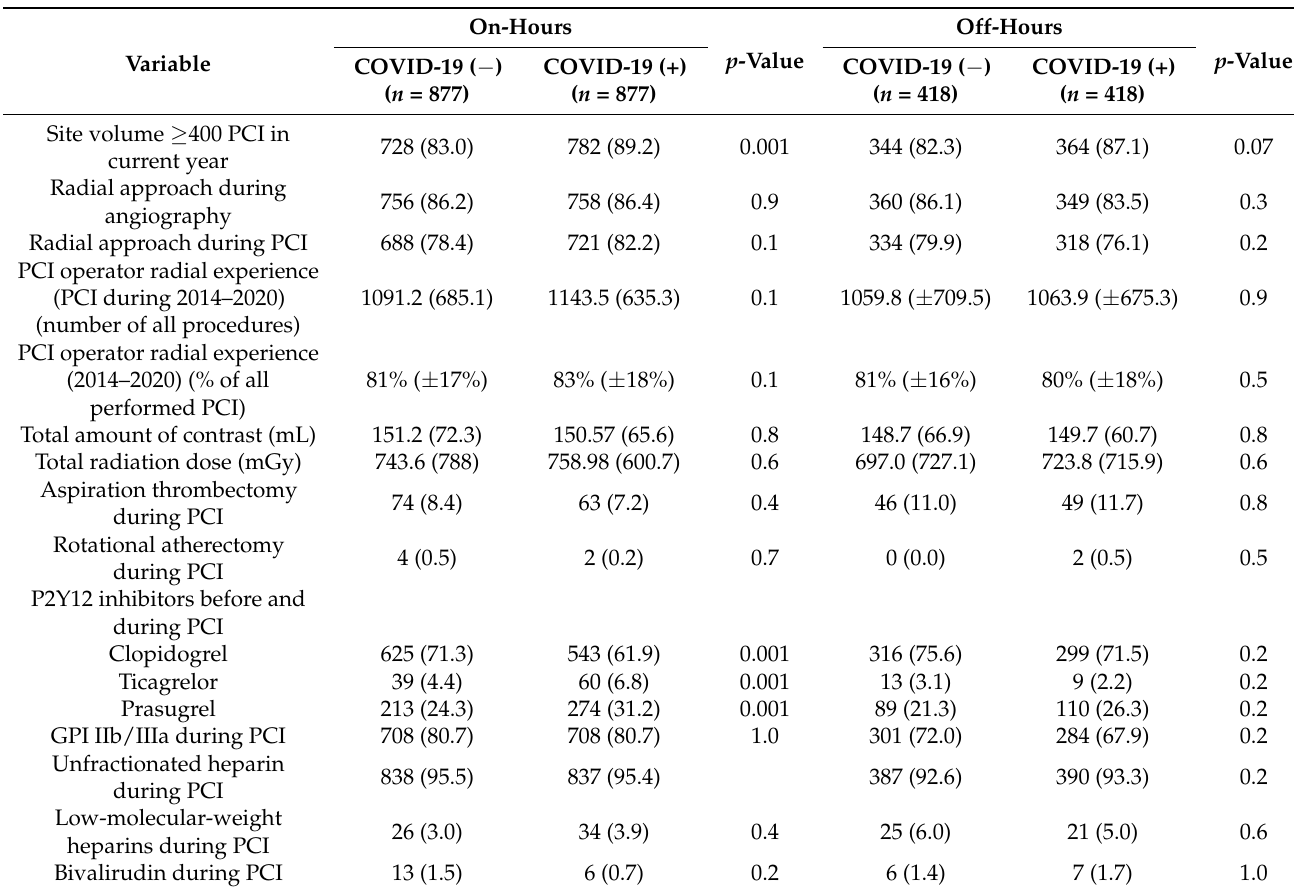
Table 3. Percutaneous coronary intervention details after propensity match